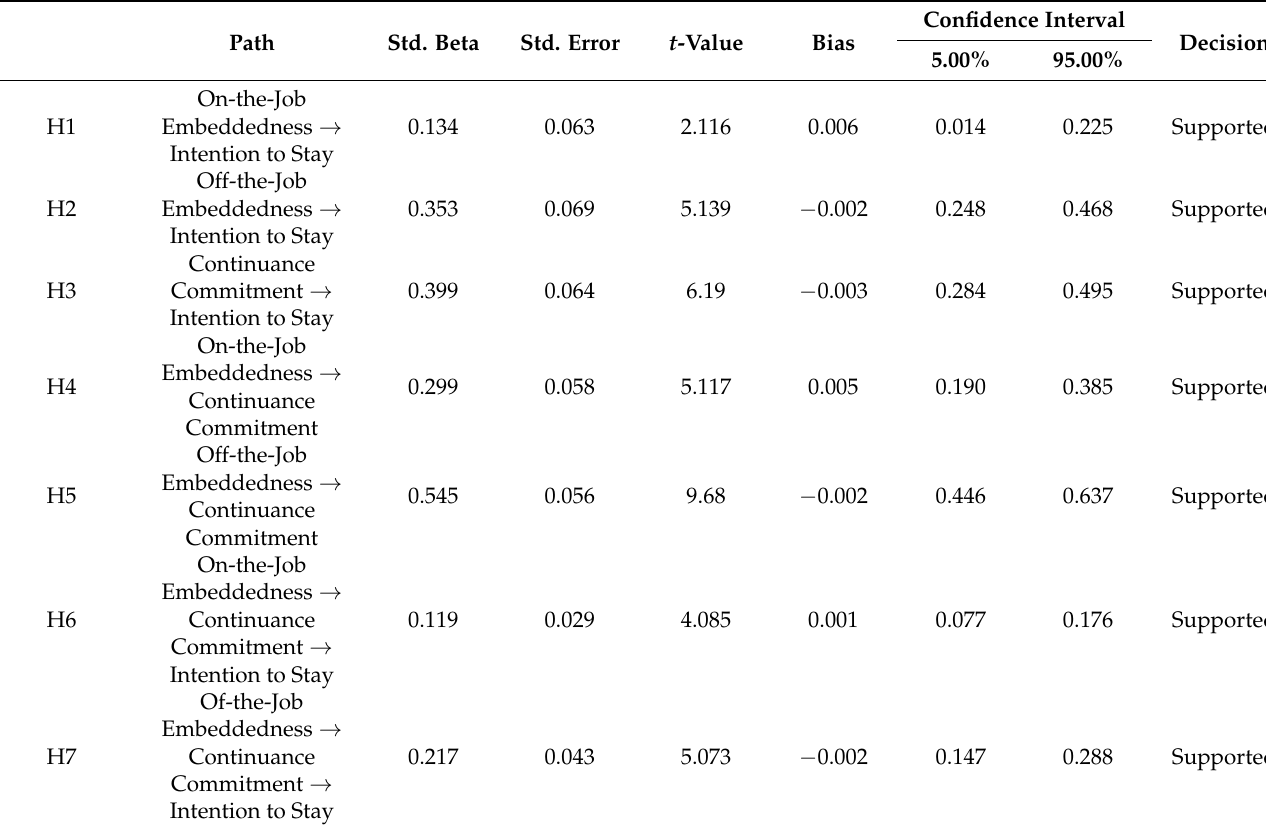
Table 5. Results of Bootstrapping for Structural Model